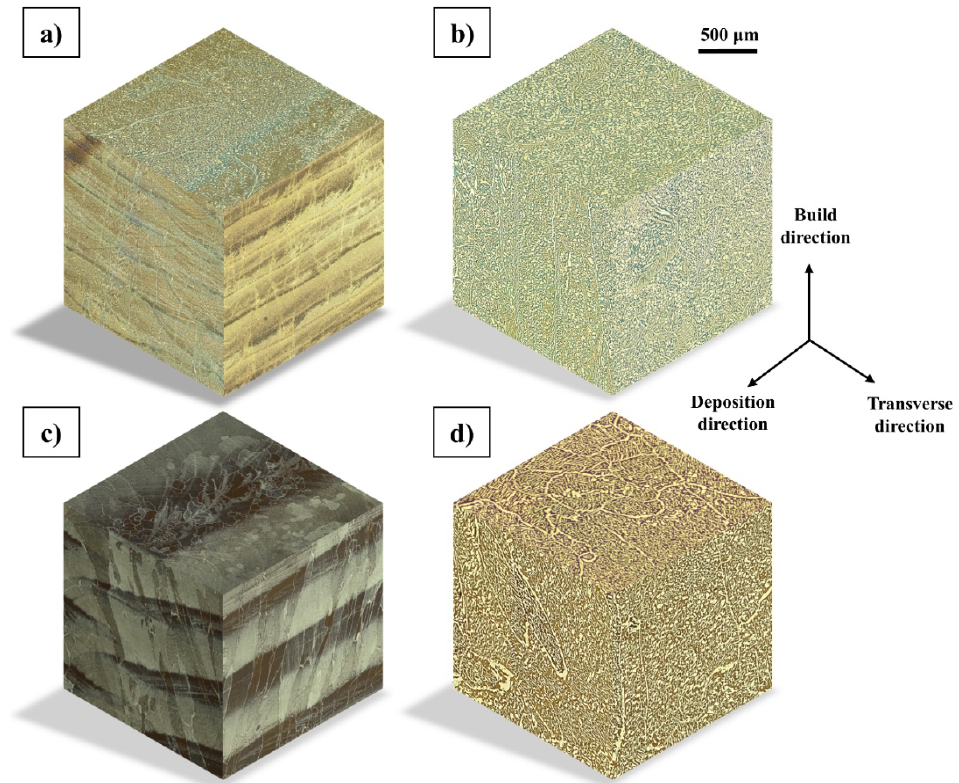
Figure 8. The 3D microstructures of laser metal deposited block and cylinder produced by light optical microscopy. ( a ) As-deposited block, ( b ) heat-treated block, ( c ) as-deposited cylinder, and ( d ) heat-treated cylinder. An inhomogeneous microstructure in as-deposited condition and homogeneous distribution of ferrite (dark) and austenite (bright) after heat treatment is shown.